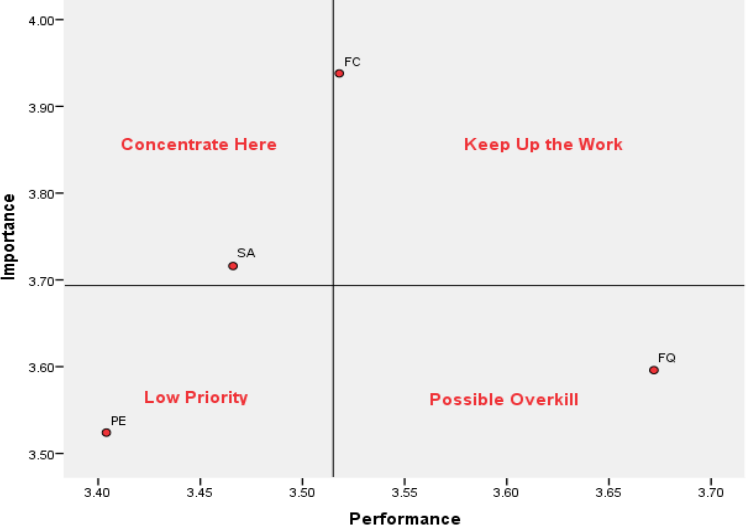
Figure 1. Results of IPA analysis for factors.